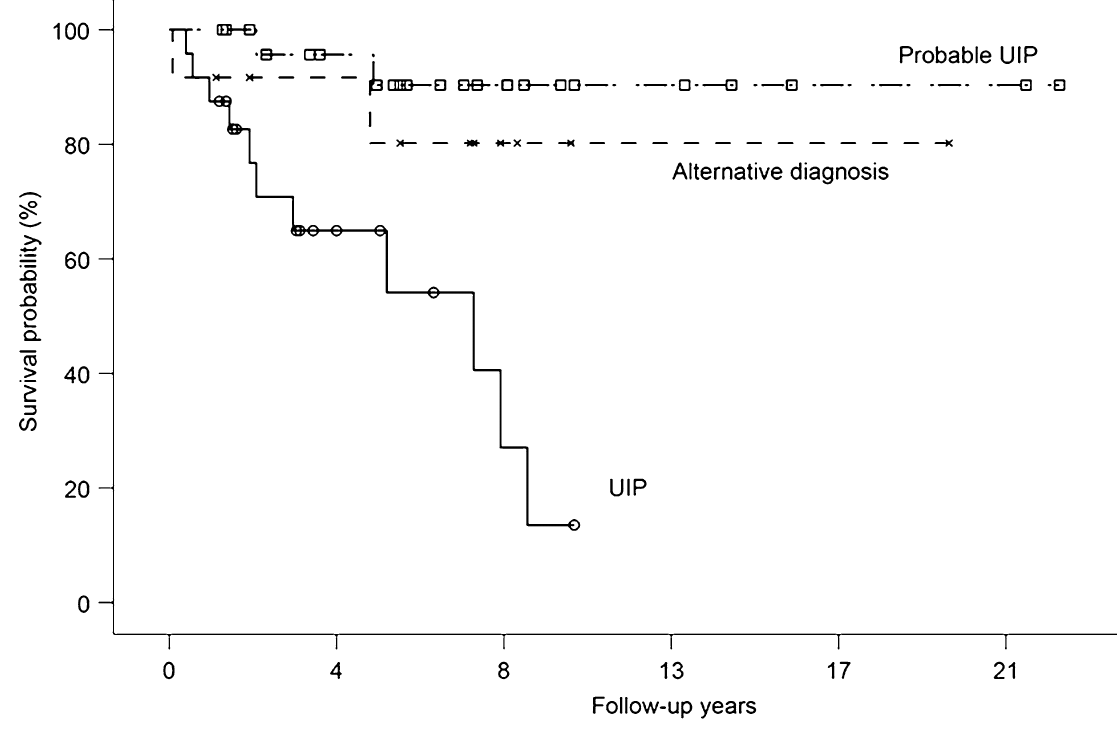
Figure 2. Kaplan–Meier curves of patients with SJS-ILD according to HRCT patterns. Cross marks, open circles, and open squares show censored cases in the alternative diagnosis, UIP, and probable UIP groups, respectively. The prognosis of UIP was significantly different from that of the others (vs. probable UIP; P < 0.001, vs. alternative diagnosis; P = 0.008, Tukey–Kramer test). The prognosis was not significantly different between probable UIP and alternative diagnosis ( P = 0.294, Tukey–Kramer test). HRCT high-resolution computed tomography, ILD interstitial lung disease, SJS Sjögren syndrome, UIP usual interstitial pneumonia.